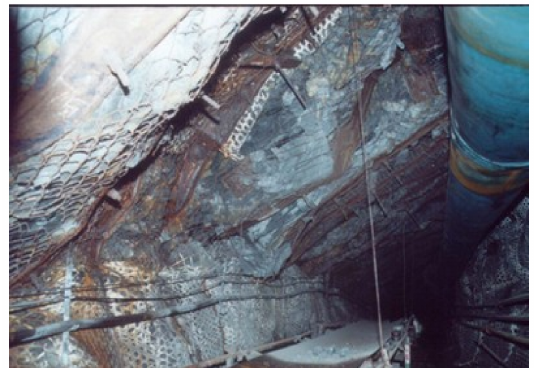
Figure 3. Broken roadway supported by normal right-hand threaded steel bolt.